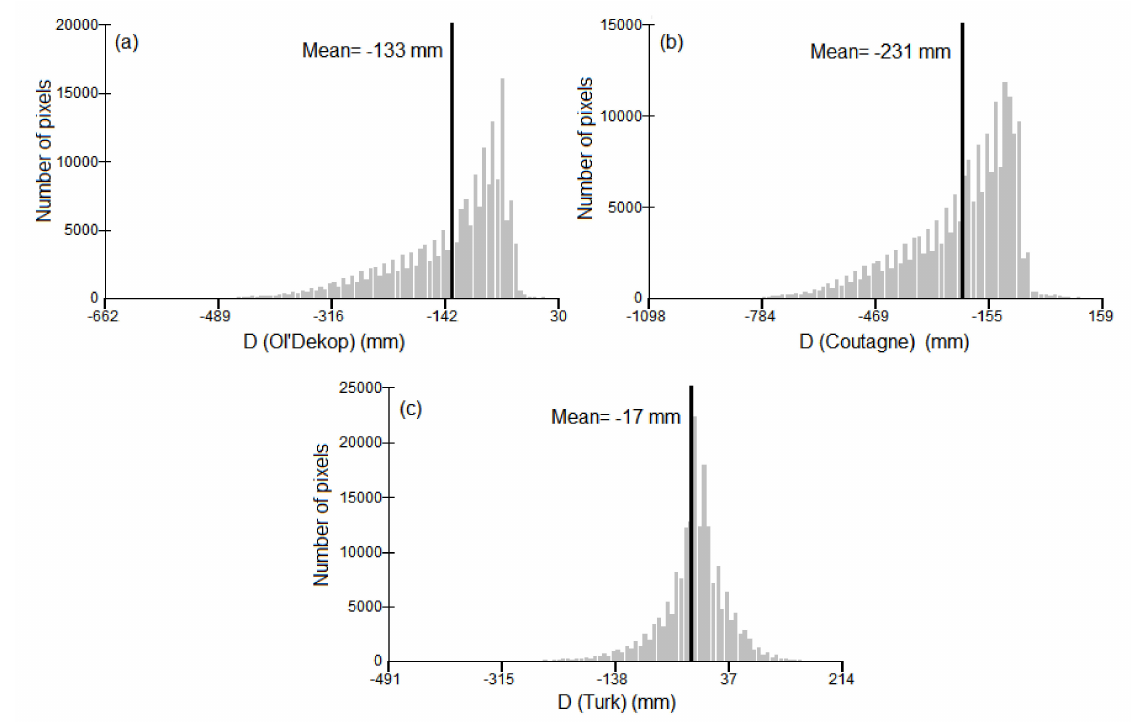
Figure 7. Frequency histograms of mean annual difference D between LOSW-ET ( IR = 0) and ( a ) ET D Oldekop, ( b ) ET C Coutagne and ( c ) ET T Turk for the period 1950–2000.